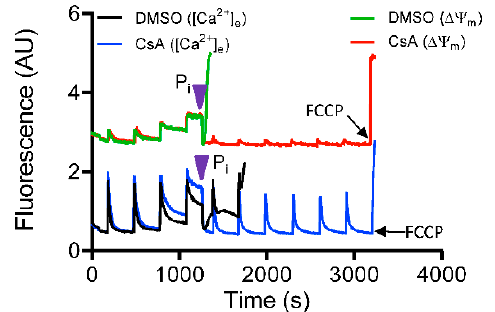
Figure 8. Mitochondrial Ca 2 + modulation by CsA is phosphate (P i )-dependent. Representative traces show change in extra-matrix Ca 2 + fluorescence (Fura-4F Ratio) and ∆Ψ m during consecutive 20 µ M CaCl 2 boluses to induce mPTP opening in P i -depleted mitochondria. P i was added (purple arrowhead) at threshold point when mitochondria exhibited limited uptake of Ca 2 + from the buffer.